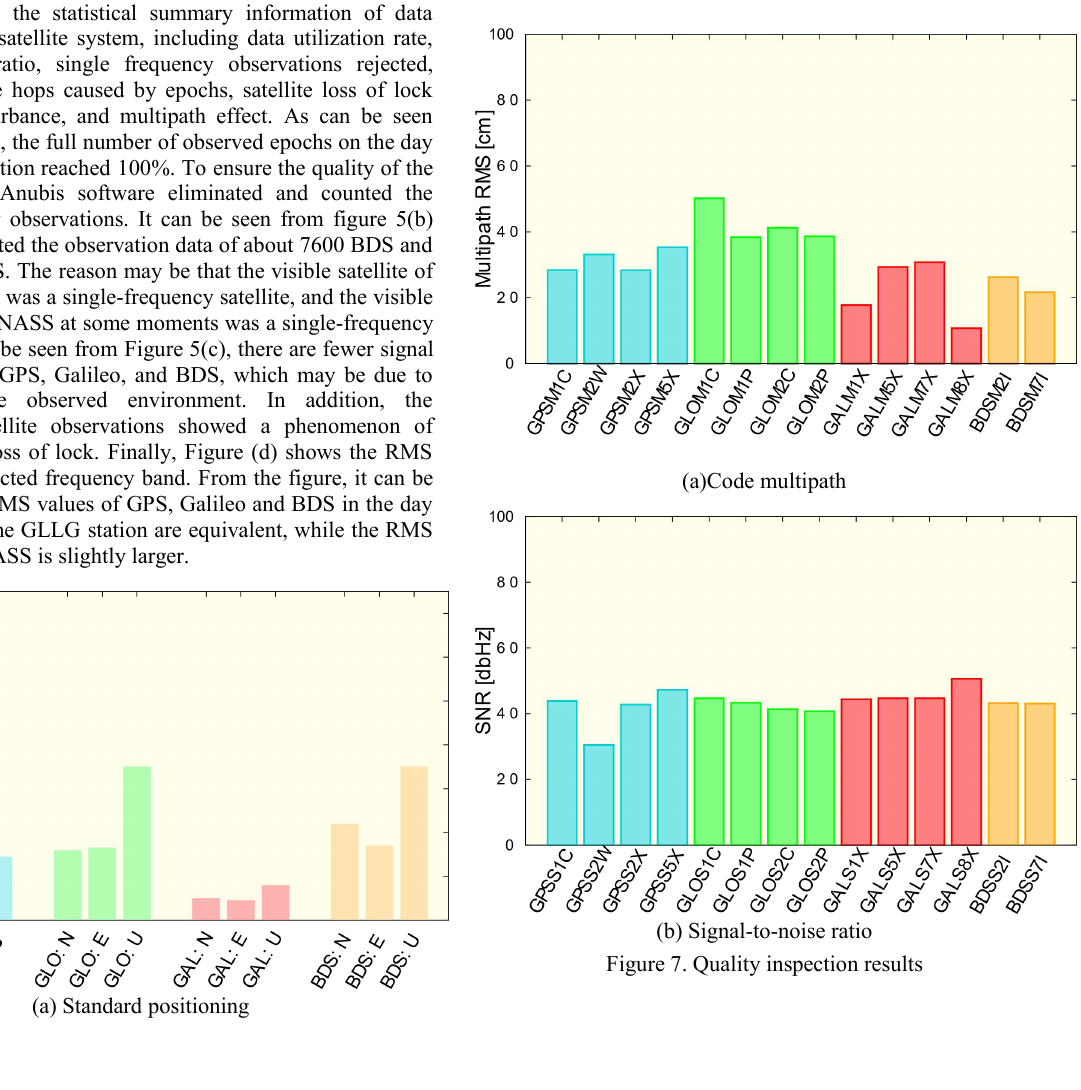
Figure 6. Schematic diagram of positioning error